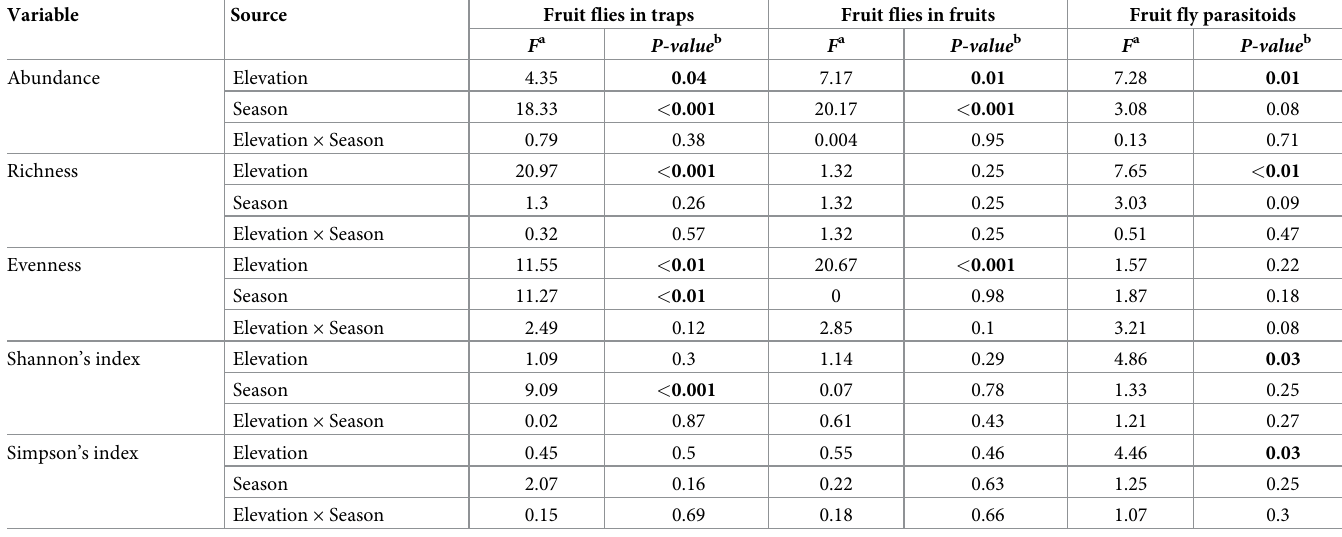
Table 1. Results of 2-way analysis of variance for the effects of elevation and season, and the interaction between these two factors, on fruit flies and their parasit- oids in guava orchards. Variable